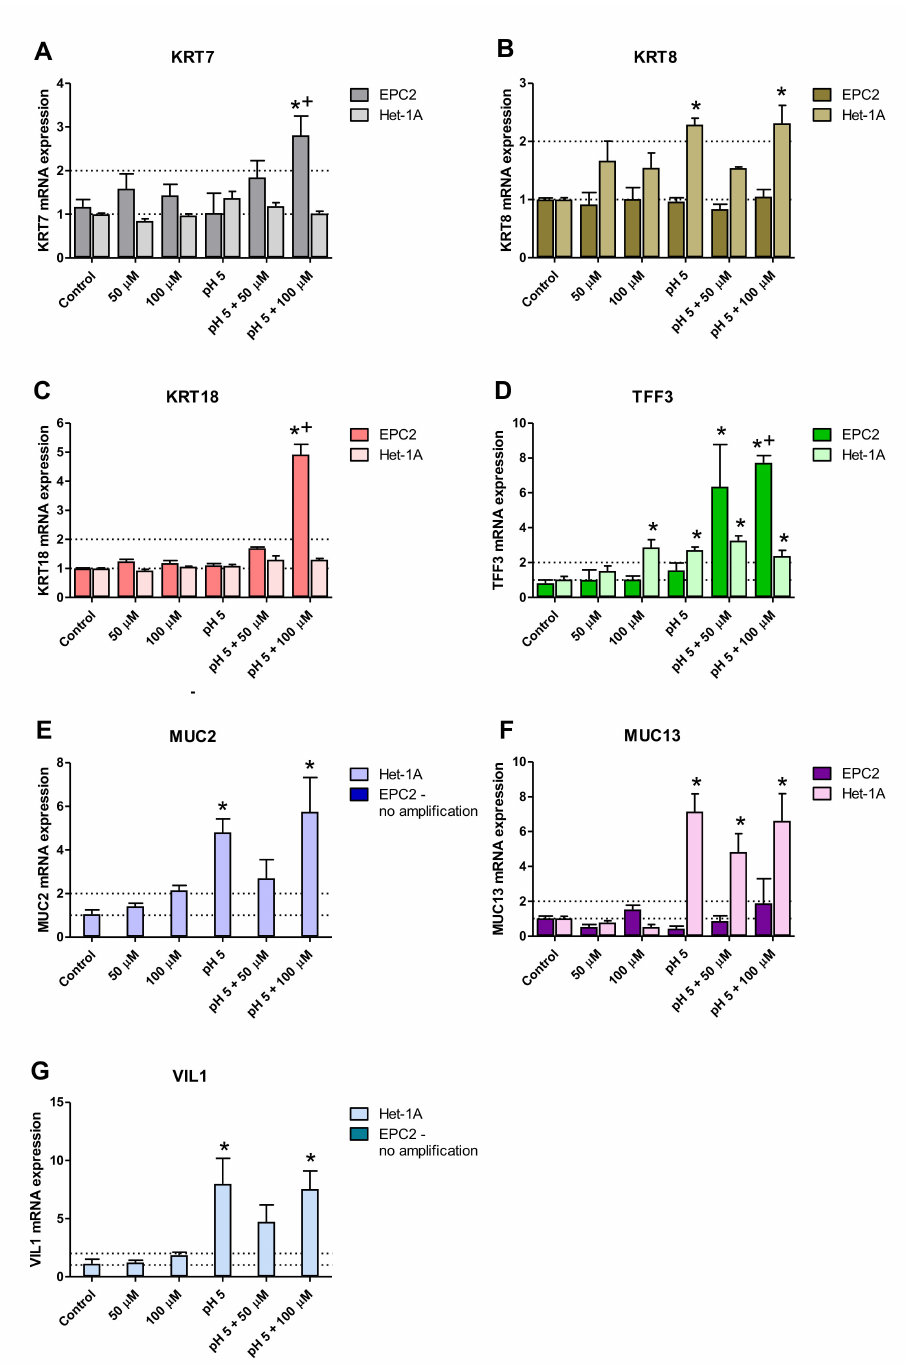
Figure 5. Columnar epithelium-specific mRNA expression upon incubation of Het-1A and EPC2 cells with bile mixture (BM) at pH 5.0. Het-1A and EPC2 cell lines were incubated with BM (50 µ M and 100 µ M) in acidified medium (pH 5.0) or regular medium for six consecutive days and squamous epithelium-specific mRNA expression was analyzed by real-time PCR ( A – G ). PCR reaction was performed in duplicates and quantified using ACTB / GAPDH as reference genes. Data from representative three independent experiments are shown as the mean ± SEM. Significant change in gene expression after six days of treatment as compared with untreated control cells is indicated by an asterisk (*) ( p < 0.05). A cross ( + ) indicates a significant change as compared with cells incubated with pH 5.0 alone ( p <